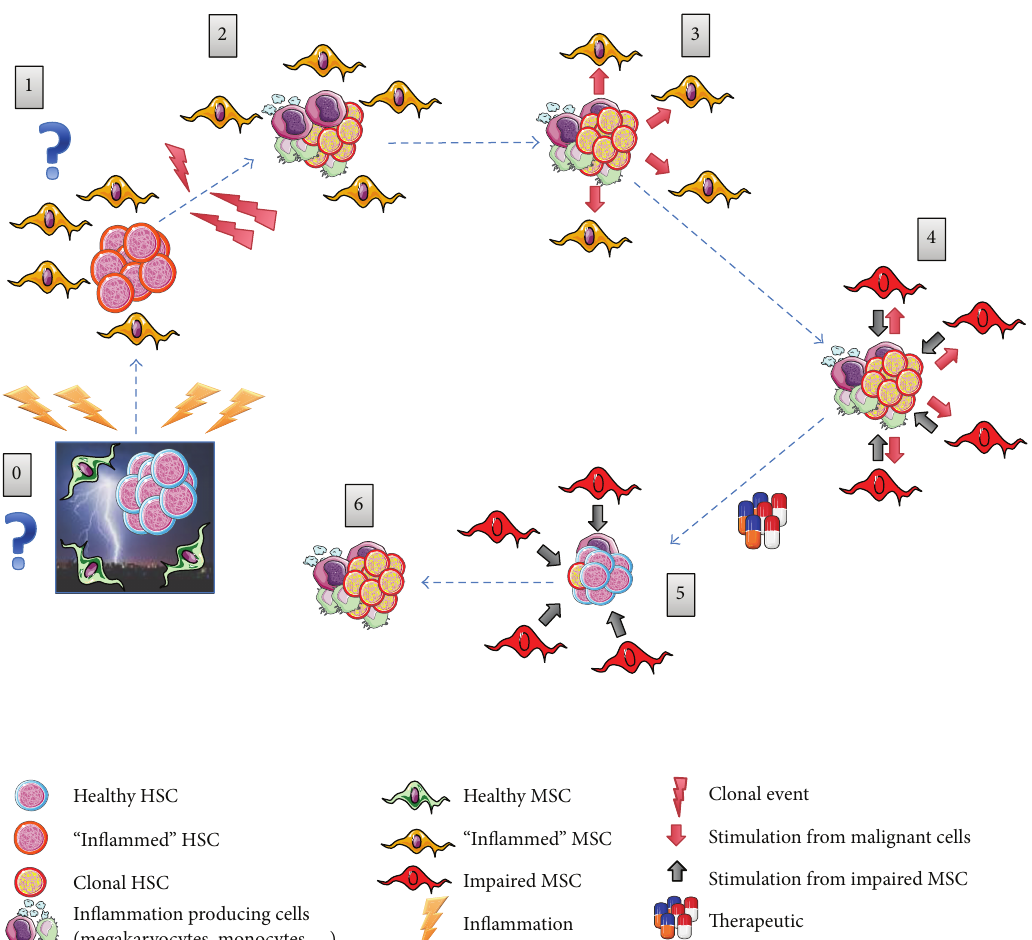
Figure 4: Proposal of a natural history of hematopoietic and stromal cell interactions in bone marrow from PMF patients. The highly inflammed bone marrow environment in PMF is compared to being hit by a “storm” of cytokines [12] (0). (1) This inflammatory environment could involve hematopoietic stem cells (HSCs) and/or mesenchymal stromal cells (MSCs). (2) Clonal events (that would be favored/driven by inflammation (?) [13]) would give rise to clonal hematopoietic cell(s) which will further differentiate into megakaryocytes and monocytes and produce large amount of inflammatory cytokines. (3) These cytokines would modify the bone marrow microenvironment, leading (4) to a permanent impairment of MSCs and a deterioration of the hematopoietic niche. (5) Impaired MSCs would influence malignant hematopoietic cells in an altered crosstalk and over time, MSCs would become inflammatory imprinted. (5) As a result of treatment, the number of malignant hematopoietic cells will reduce. However, the influence of inflammatory imprinted MSCs that would have acquired inherited impaired functions will continue. Unless treated, disease MSCs may continue interacting with HSC and contribute to relapse of the disease